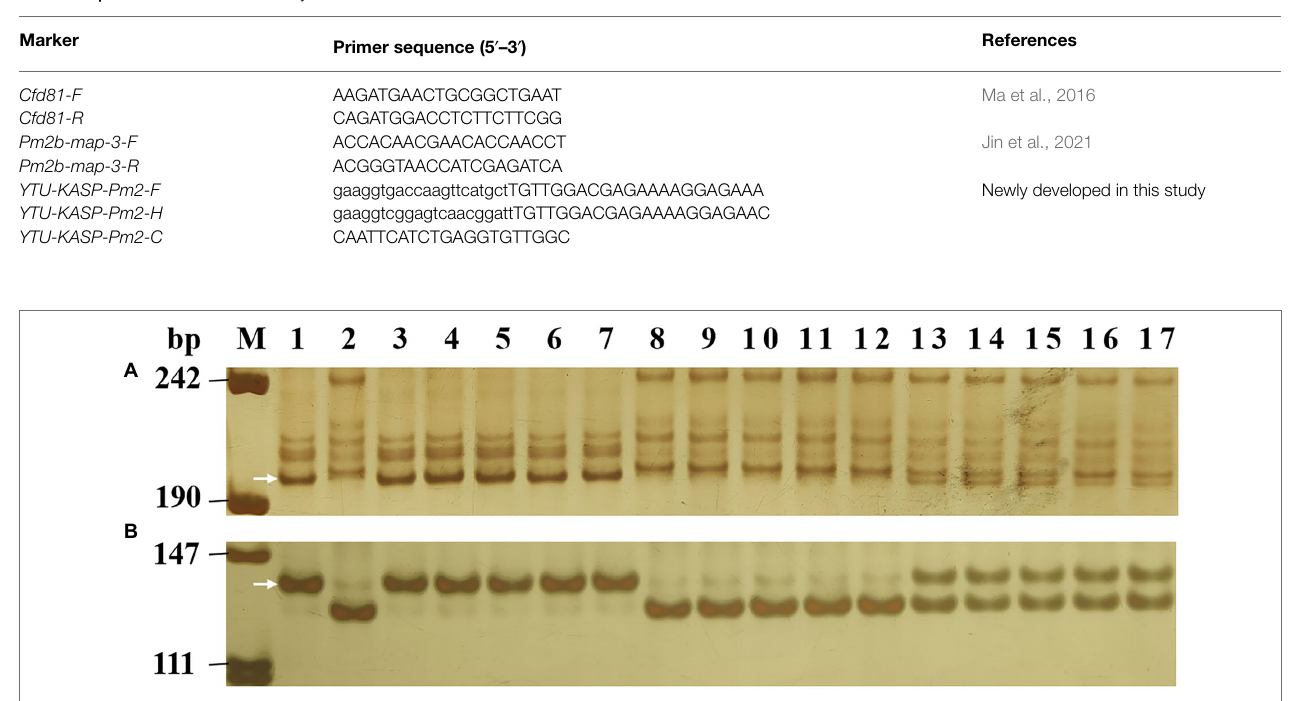
FIGURE 1 | Amplification patterns of the Pm2 -linked marker Cfd81 (A) and diagnostic marker Pm2b-map-3 (B) in genotyping Lande 677 ( Pm2 donor), Hanmai 13 and random selected F 2:3 families of Lande 677 × Hanmai 13. Lane M, pUC18 Msp I; lane 1, Lande 677; lane 2, Hanmai 13; lanes 3–7, homozygous resistant F 2:3 families; lanes 8–12, heterozygous F 2:3 families; and lanes 13–17, homozygous susceptible F 2:3 families. The white arrows indicate the polymorphic bands in Lande 677.